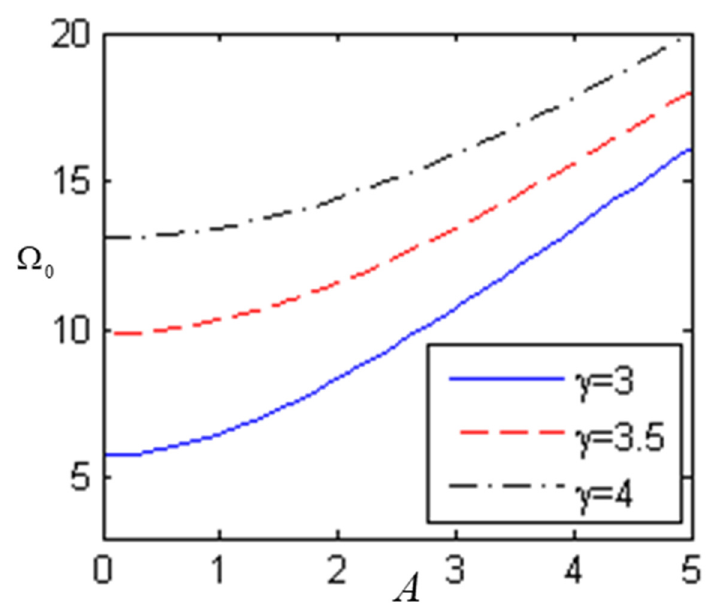
Figure 6. The variation in nonlinear frequencies with amplitudes above different supercritical axial speeds.